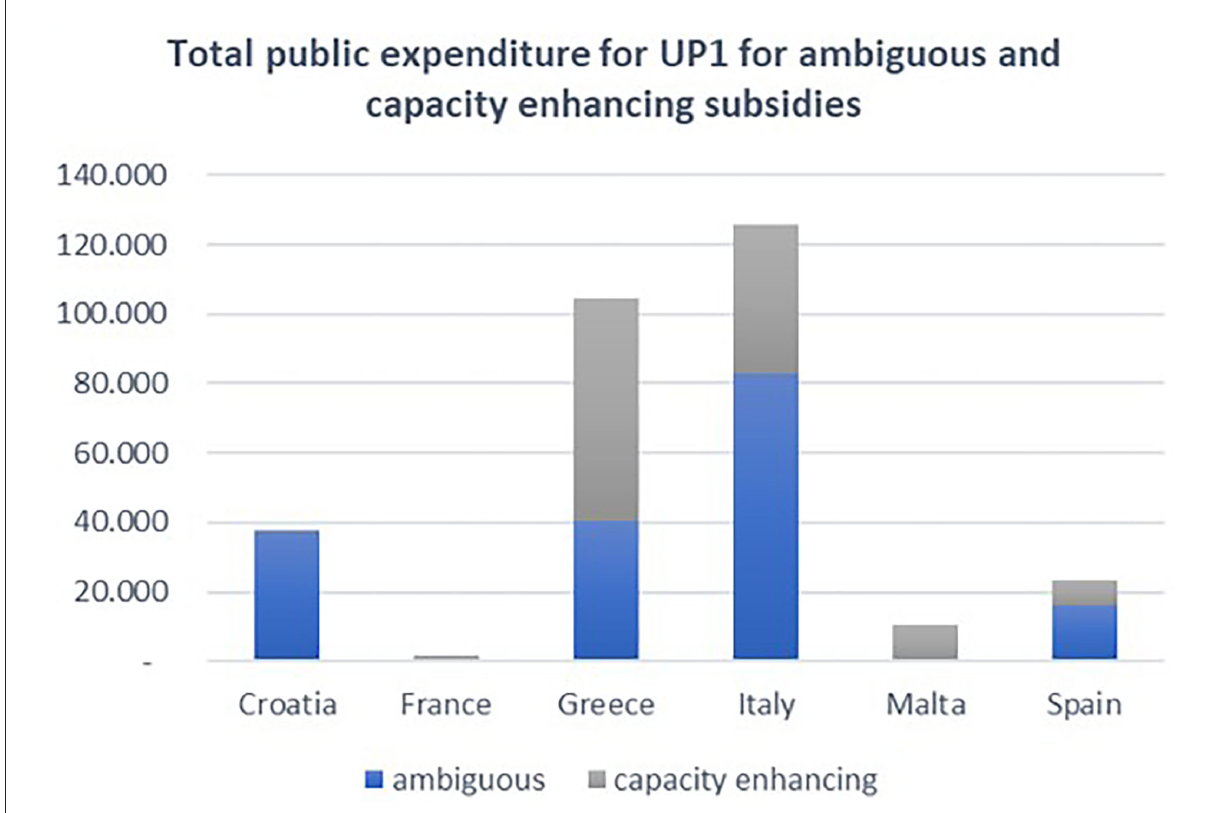
FIGURE13 Total public expenditures for the UP1 ambiguous and capacity-enhancing measures by EU MSs. Elaboration on data from the EMFF List of Operations.